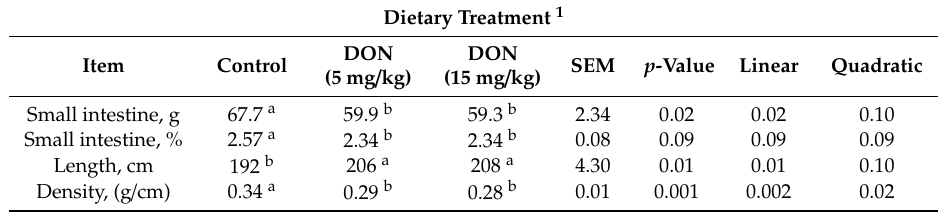
Table 4. E ff ects of DON-contaminated feed (5 and 15 mg / kg) on small intestine morphology of broiler chickens.